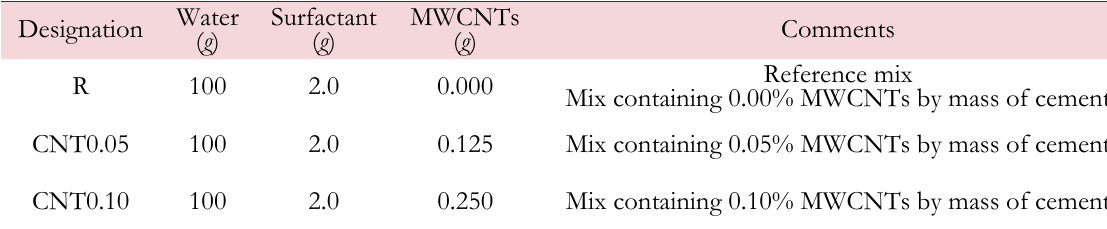
Table 2: Composition of solution containing dispersed MWCNTs.